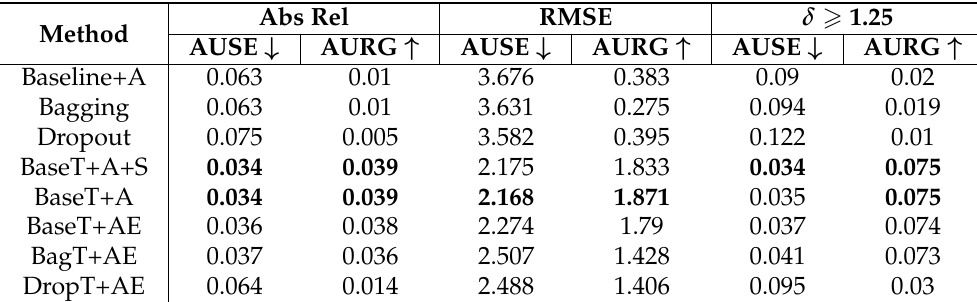
Table 3. The results of our different strategies for depth uncertainty evaluation. The best results in each metric are shown in bold.